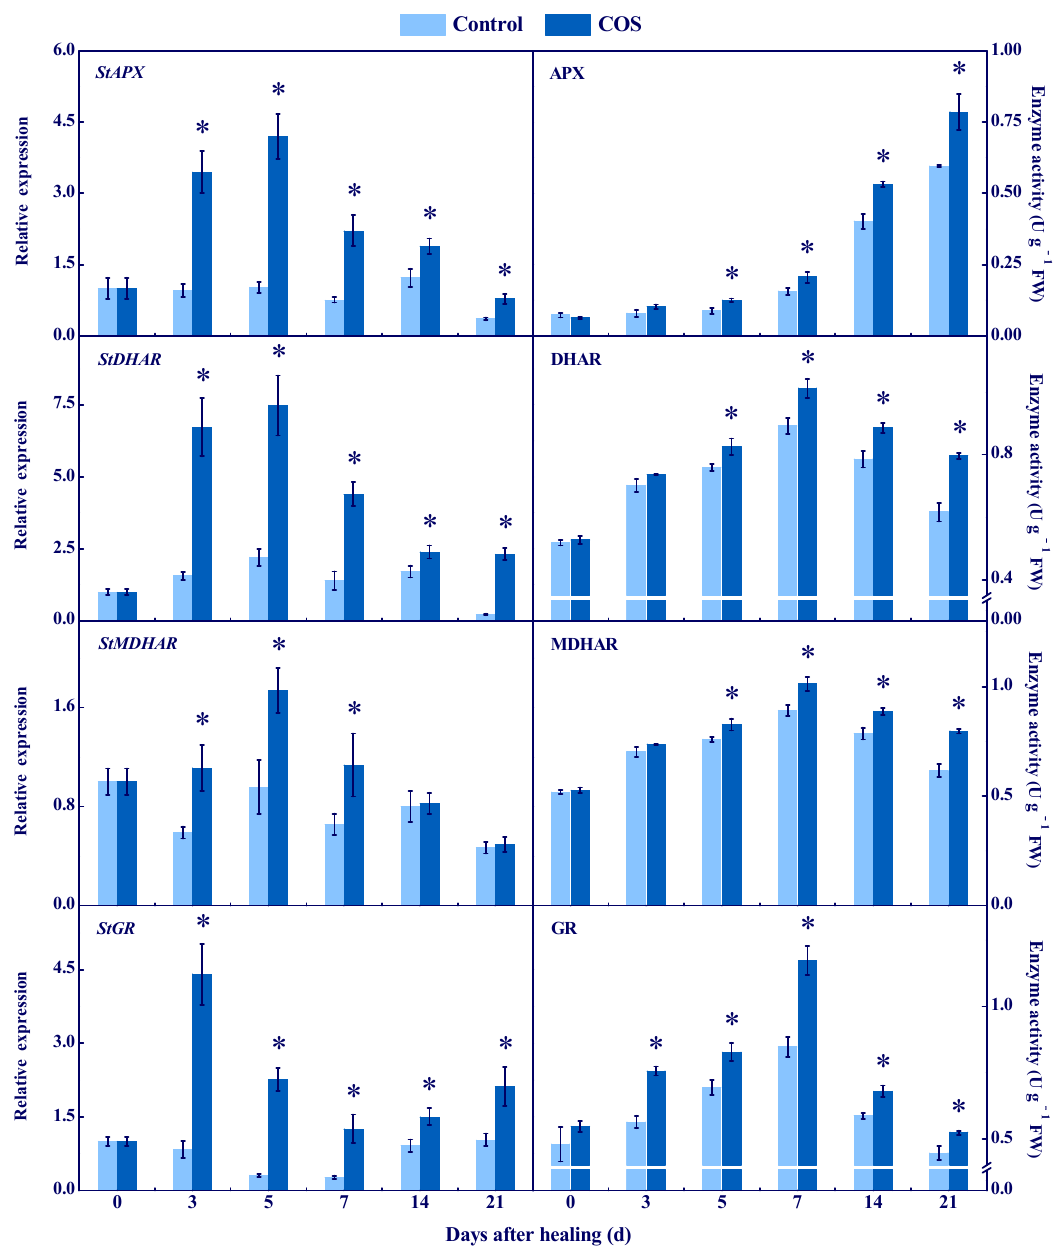
Figure 4. Effect of COS treatment on the relative expression of StAPX , StDHAR , StMDHAR, and StGR , and the activities of APX, DHAR, MDHAR, and GR at wounds of potato tubers during healing. Bars indicate standard error. Asterisks denote significant differences ( p < 0.05).